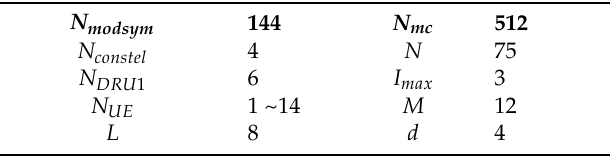
Table 3. Parameters used in performance evaluation.